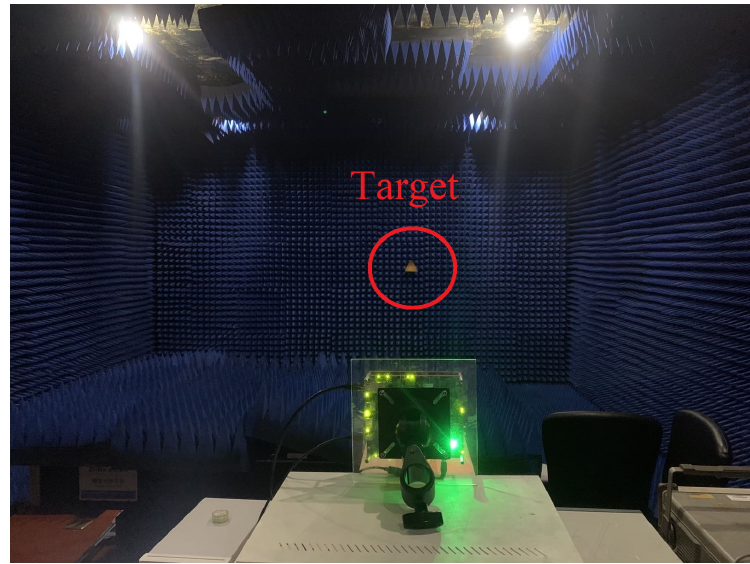
Figure 13. Single-target scenario for dataset